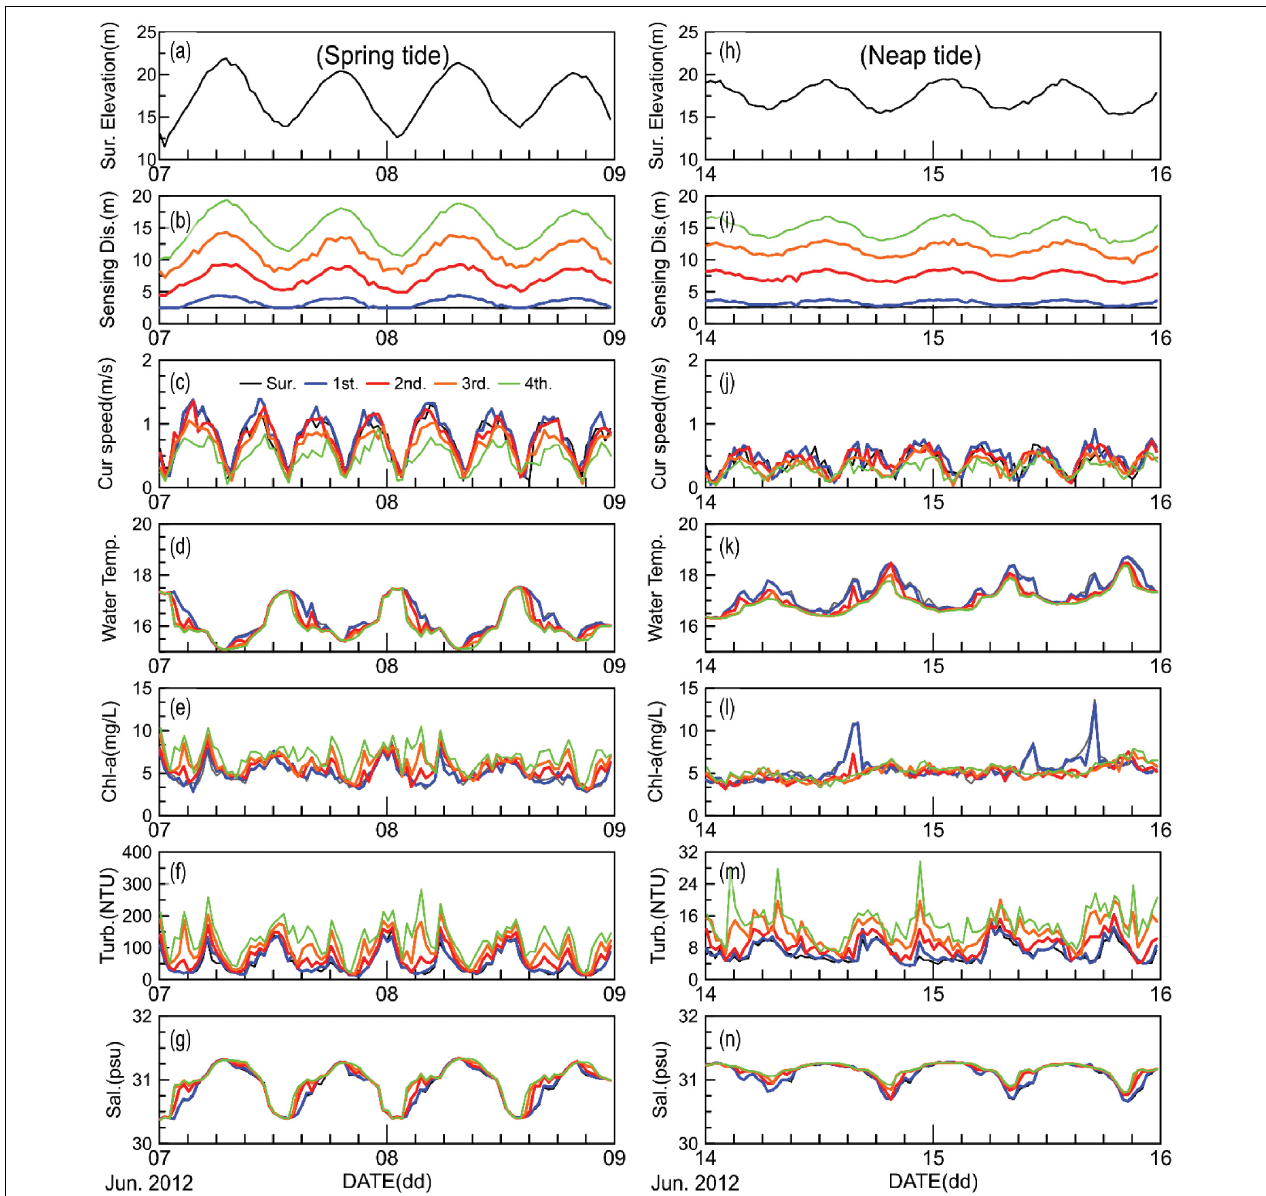
FIGURE 12 | Time variation of the (a) surface elevation, (b) distances from the four internal layers to the seabed, (c) current speed, (d) water temperature, (e) Chl content, (f) turbidity, and (g) salinity over 2 days (June 7–9, 2012) during the spring tide and the time variation of the (h) surface elevation, (i) distances from the four internal layers to the seabed, (j) current speed, (k) water temperature, (l) Chl content, (m) turbidity, and (n) salinity over 2 days (June 14–16, 2012) during the neap tide. Black solid lines, water surface; blue lines, first internal layer; red lines, second internal layer; orange lines, third internal layer; and green lines, fourth internal